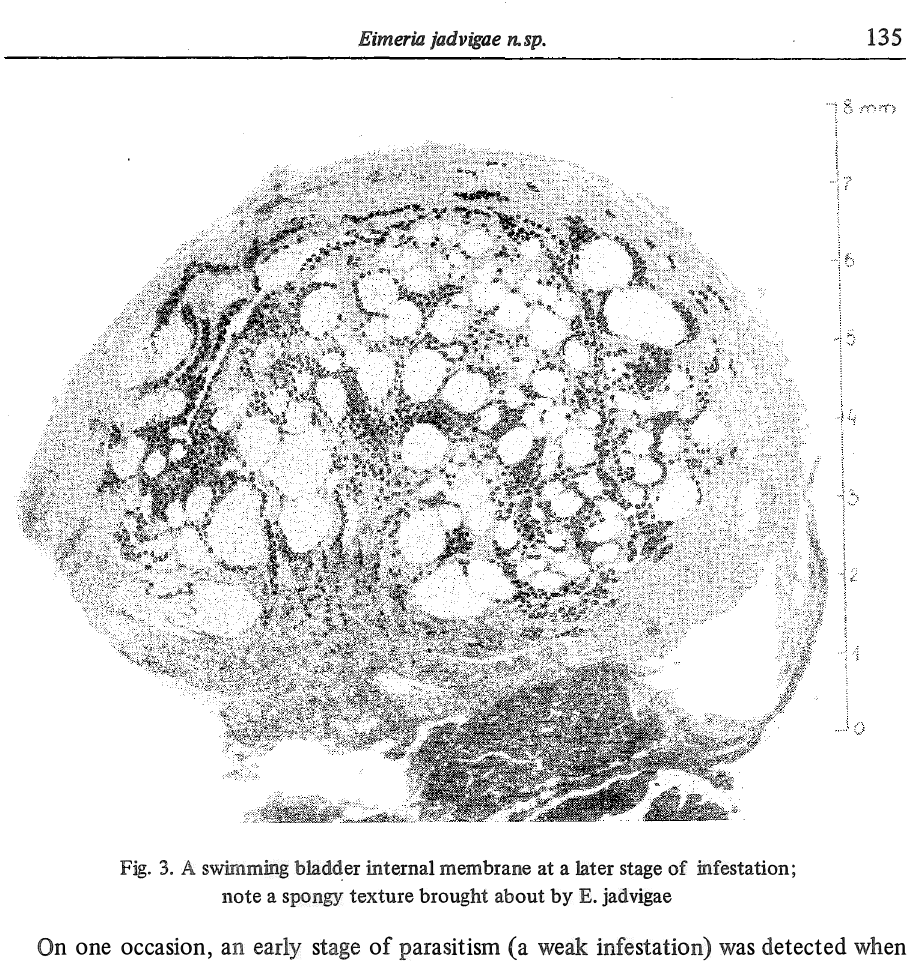
Fig. 3. A swimming bladder internal membrane at a later stage of infestation; note a spongy texture brought about by E.